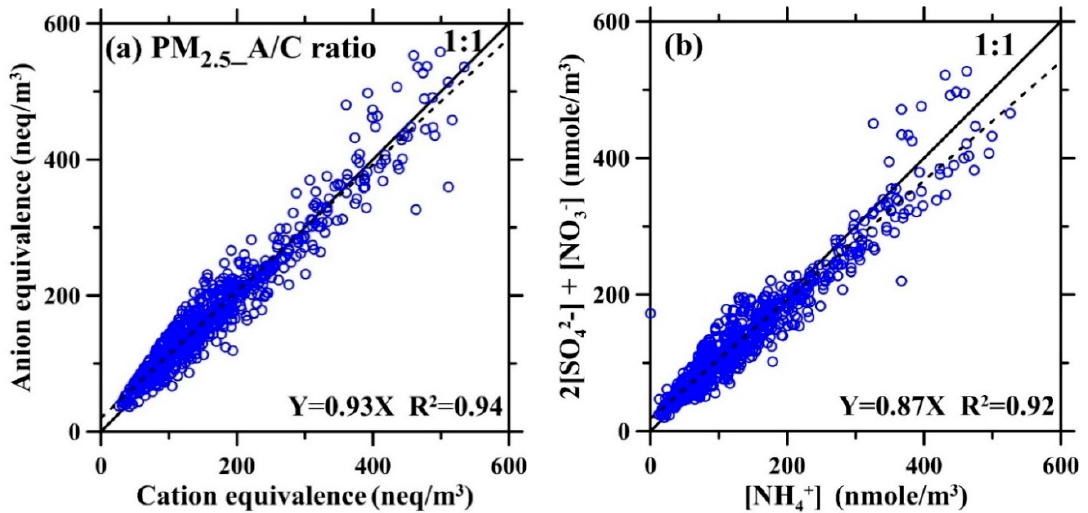
Figure 6. Plot of ( a ) anion equivalent versus anion equivalent and ( b ) 2[SO 42 − ] + [NO 3 − ] versus [NH 4+ ] measured by PPWD-PILS-IC (N = 720).